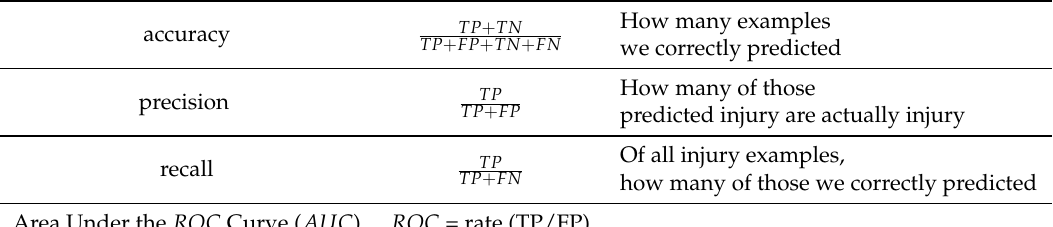
Table 2. Binary measures of predictive